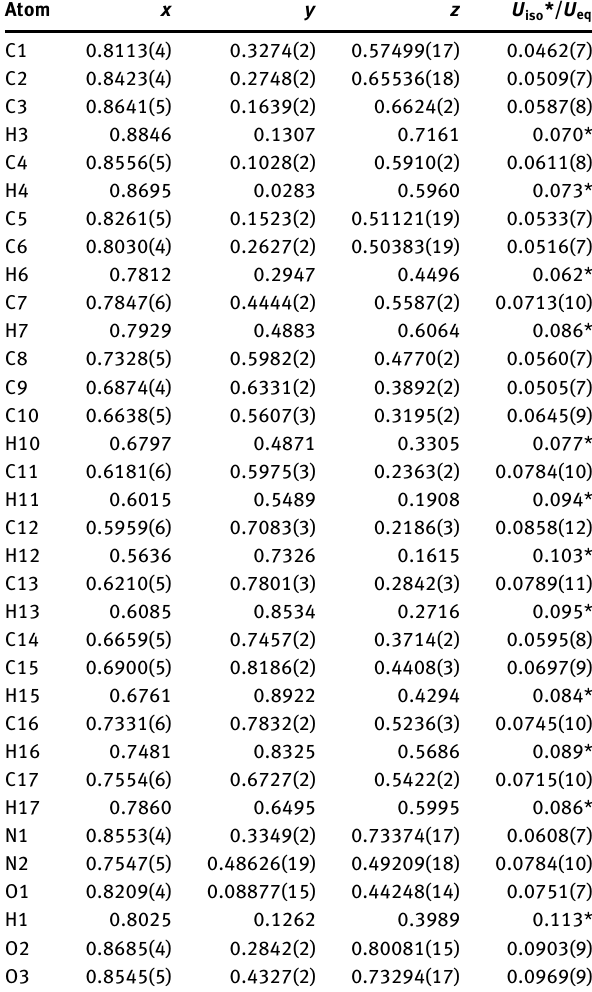
Table 2: Fractional atomic coordinates and isotropic or equivalent isotropic displacement parameters (Å 2